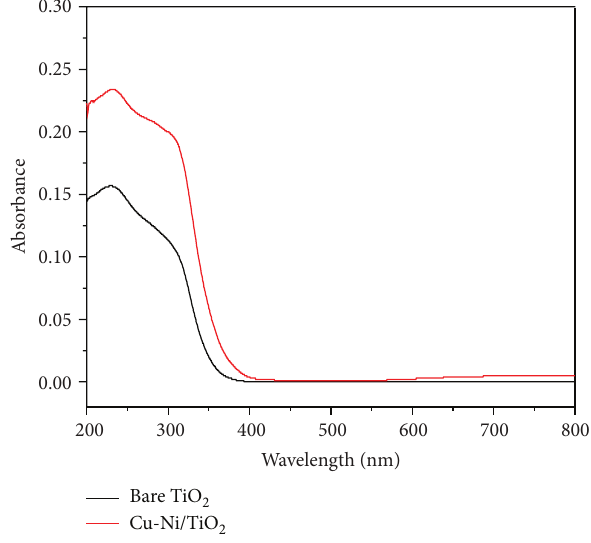
Figure 2: Absorption spectra for bare TiO 2 and bimetallic Cu- Ni/TiO 2